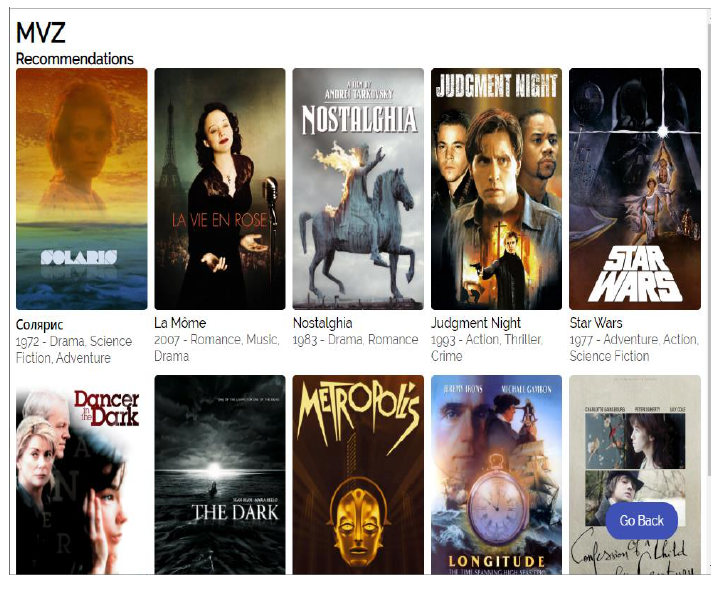
Figure 5. Search result.